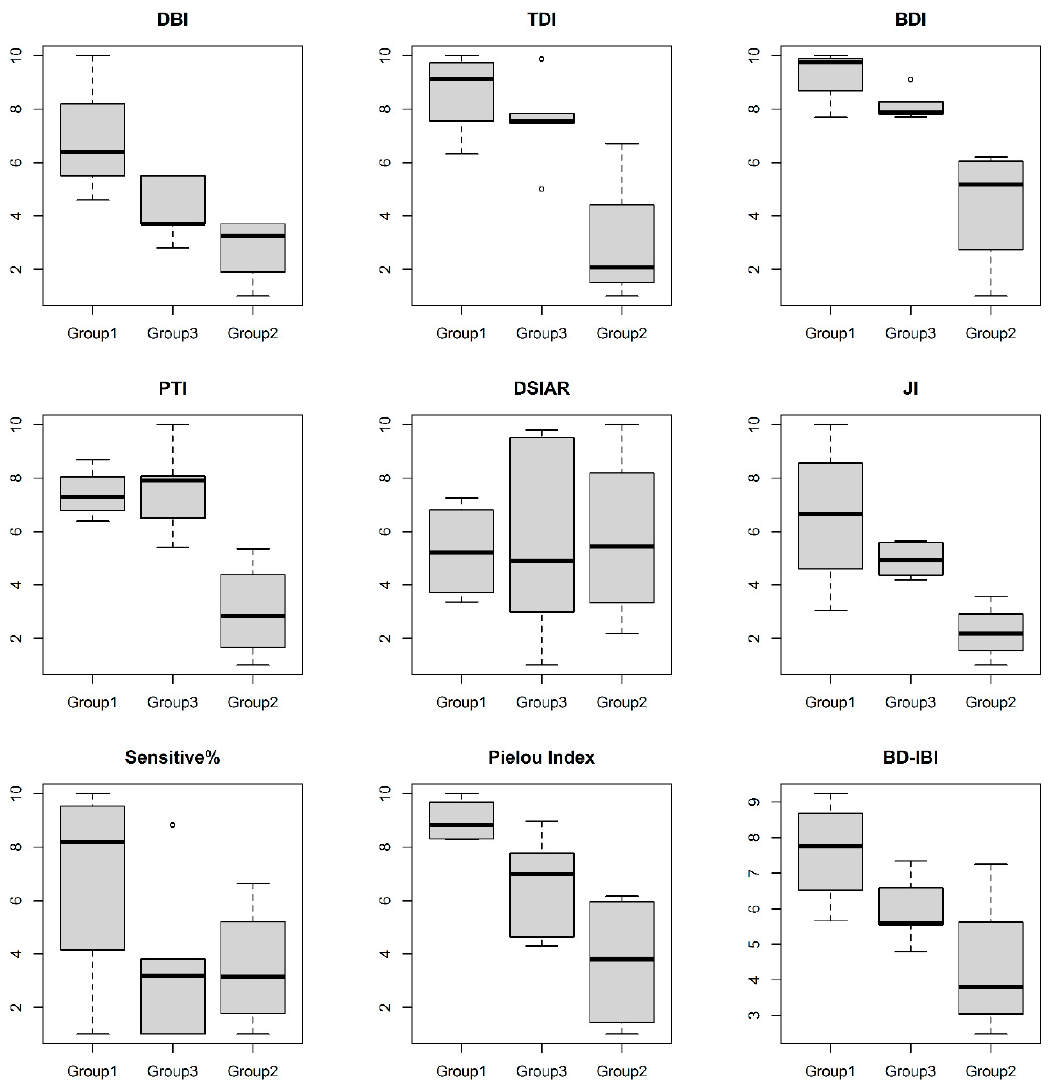
Figure 8. Box plots of eight diatom indexes and BD-IBI between different groups. Table 3. The Spearman correlation among metrics (or BD-IBI) and water quality.